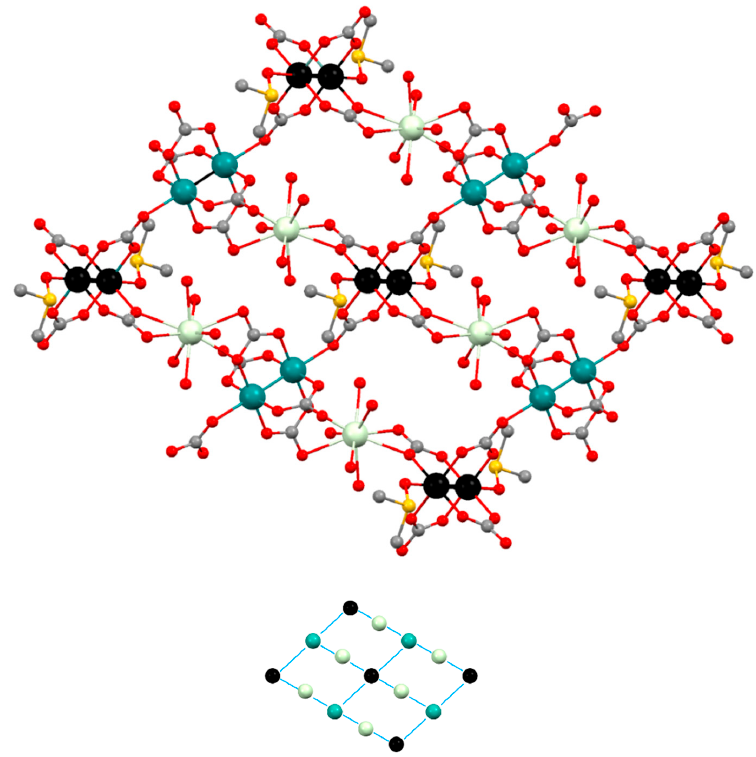
Figure 7. ( Top ): Ball and stick representation of the 2D structure of Gd β . Ruthenium: turquoise and black; gadolinium: pale green; oxygen: red; carbon: gray; sulfur: yellow. Hydrogen atoms are omitted for clarity. ( Bottom ): Simplification of the 2D net. Turquoise: [Ru 2 (CO 3 ) 4 ] 3 − units; black: [Ru 2 (CO 3 ) 4 (DMSO) 2 ] 3 − units; pale green: [Gd(OH 2 ) 5 ] 3+· units.